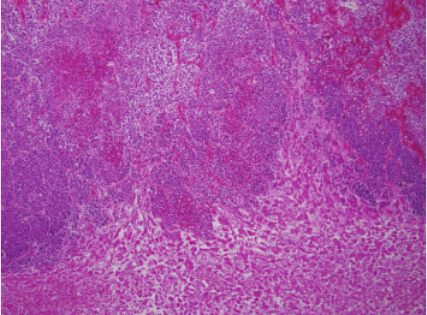
Figure5:Liverdiffuselyinvolvedbypoorlydifferentiatedsquamous cell carcinoma (low power magnification).